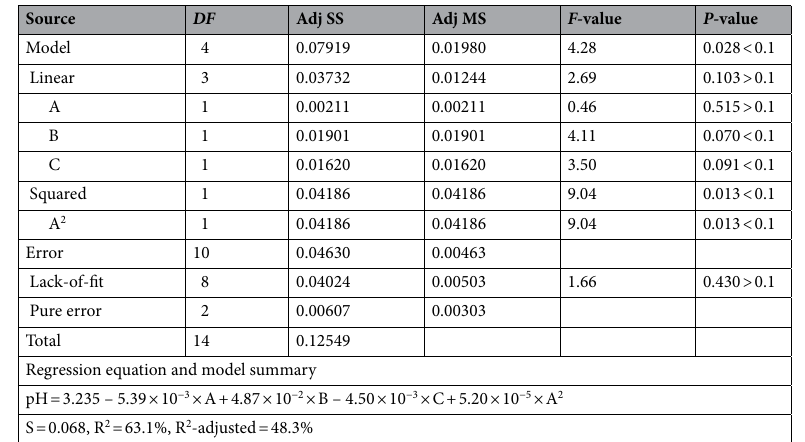
Table 2. The analysis of variance (ANOVA) table for the response surface model developed to describe the effect of the operating parameters of the pulsed radio-frequency atmospheric pressure glow discharge (pm-rf- APGD), i.e., A-DOX concentration in the flowing liquid electrode (FLE) solution (in µg mL −1 ), B-FLE solution flow rate (in mL min −1 ), and C-duty cycle for the pulse-modulated radio-frequency alternating current, on pH of DOX-containing solutions treated by pm-rf- APGD. DF: Degrees of freedom. Adj SS: adjusted sums of squares. Adj MS: adjusted mean squares. F -value: the value of the Fisher–Snedecor test. P -value: probability